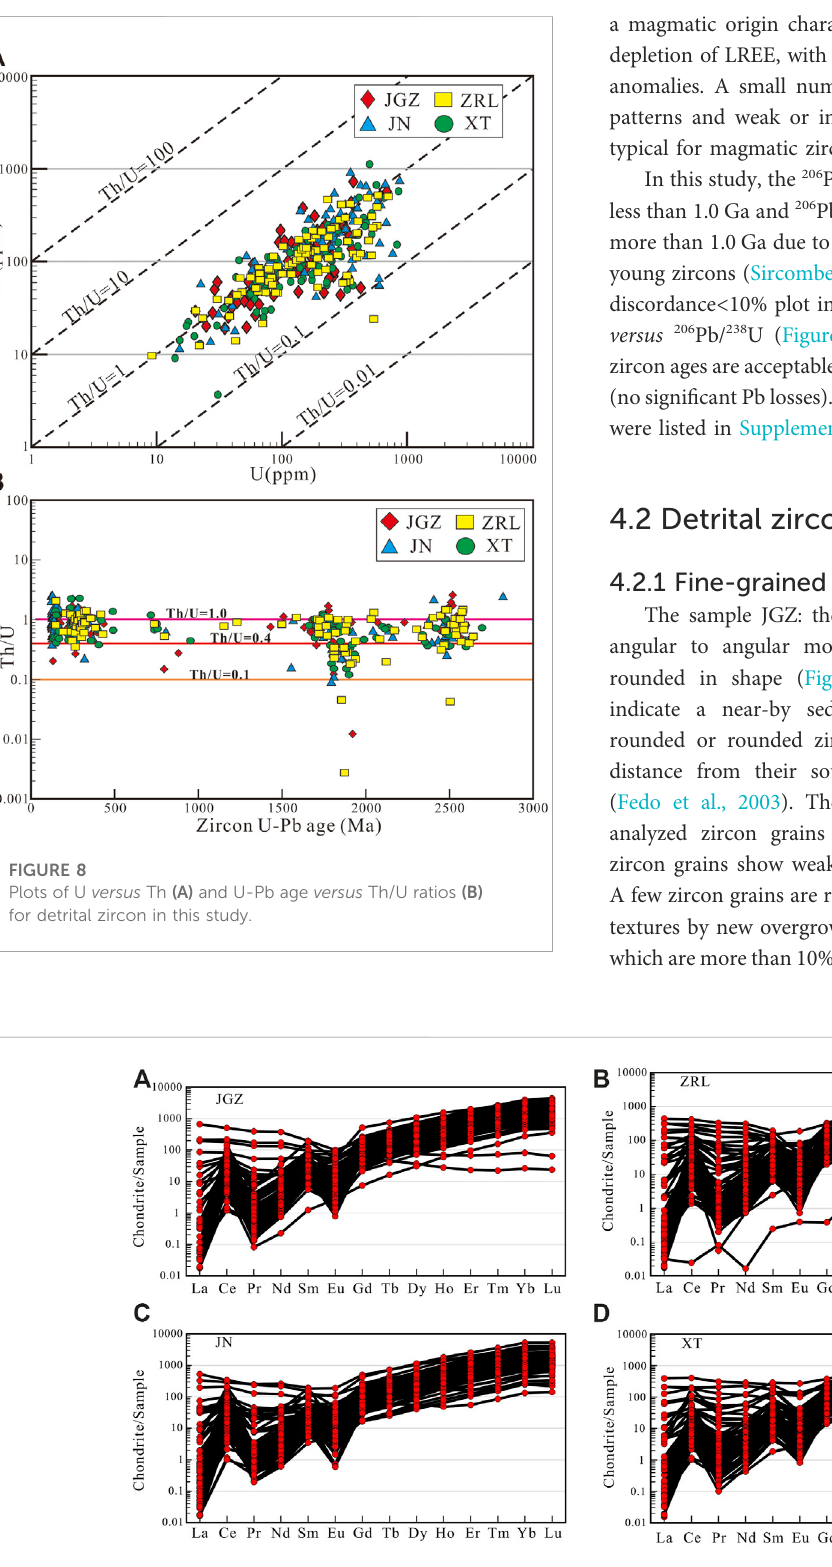
Frontiers in Earth